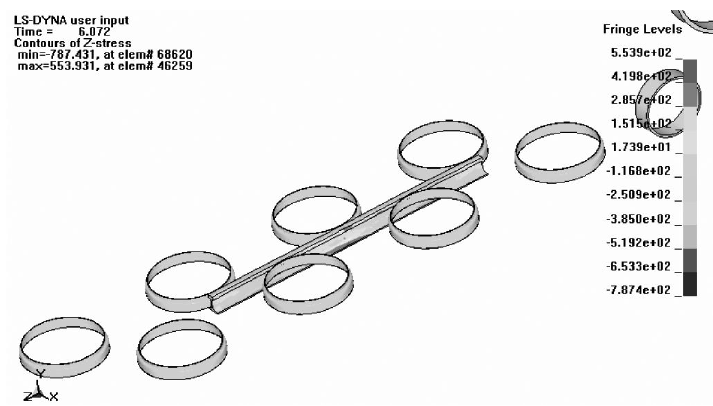
Fig. 5. Longitudinal stress during